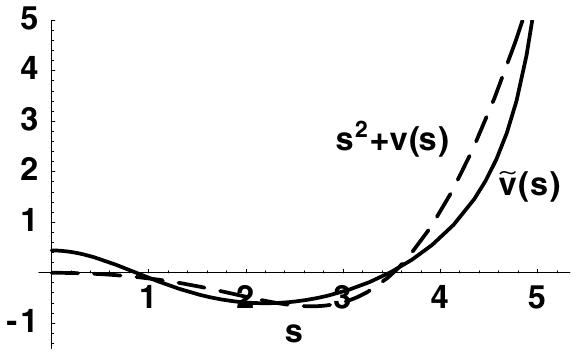
FIG. 9. The best approximation in mean square (solid line) of a numerical solution for the self-consistent equations (dashed line) for trial functions of the form (71) with (cid:7) (cid:21) 19 : 3 .